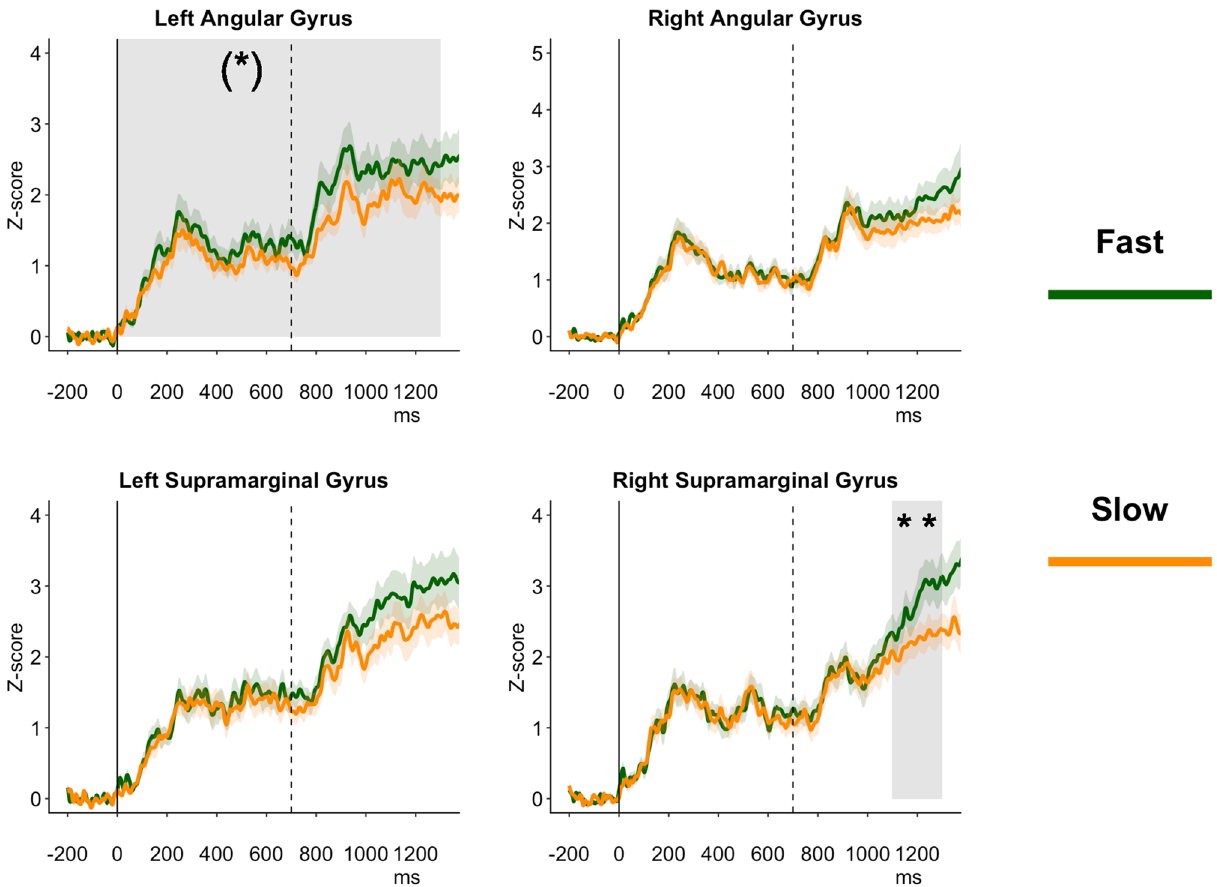
Figure 1. ROI analysis time-locked to the First Number. The figure shows the Source Activity z-scores for each Region of Interest (ROI). Each source waveform represents the average time series of z-scores of all participants within an ROI. Z-scores were calculated from source absolute values of activation. Shaded bands indicate standard errors around the mean. The gray areas and asterisks enclosed in round brackets ("(*)") highlight the time windows in which the ANOVA showed significant differences in the main effect. The asterisks without square brackets ("*") indicate the time windows in which there was a difference in the post-hoc analysis. The solid vertical lines indicate the appearance of the First Number , whereas the vertical dashed lines indicate the appearance of the Second Number . The figure was drawn by the first author of the paper—Giorgio